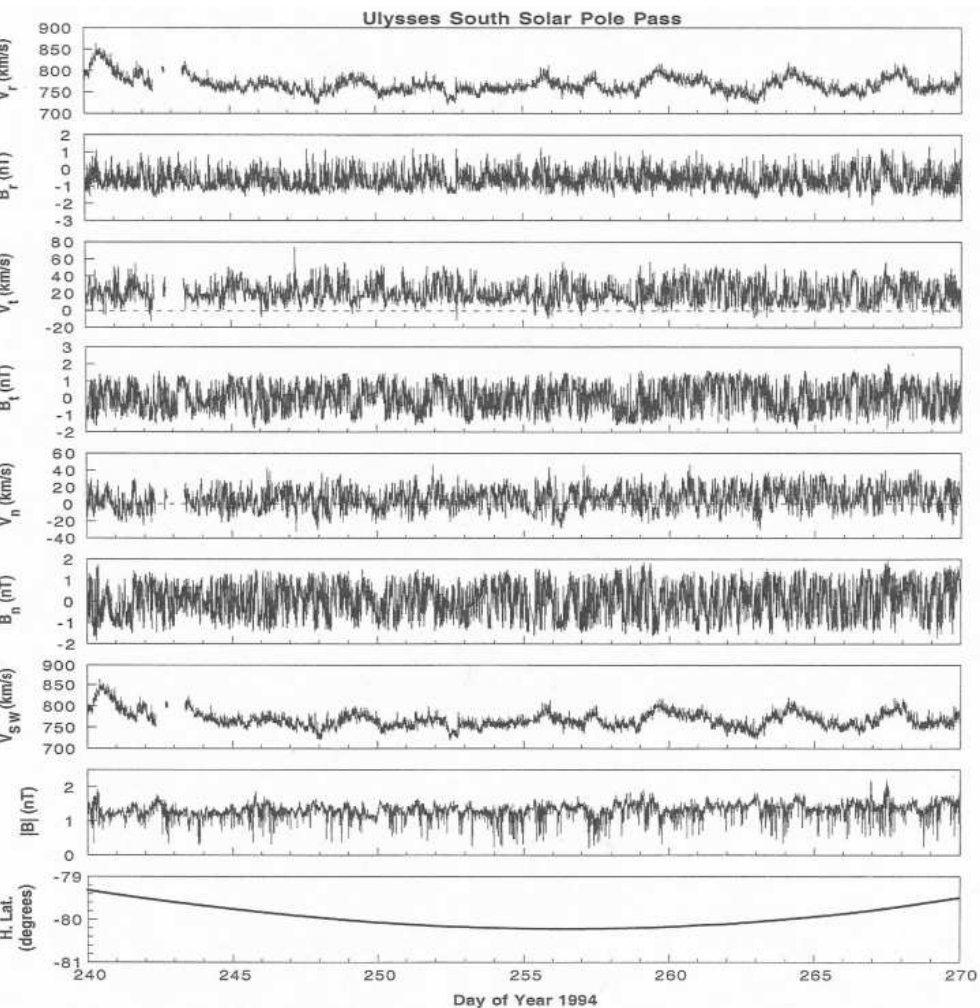
Fig. 1. The Ulysses velocity and magnetic field components for 30days over the south pole of the sun. MDs are the sharp field magnitude decreases noted in the next to last panel. Taken from Tsurutani and Ho